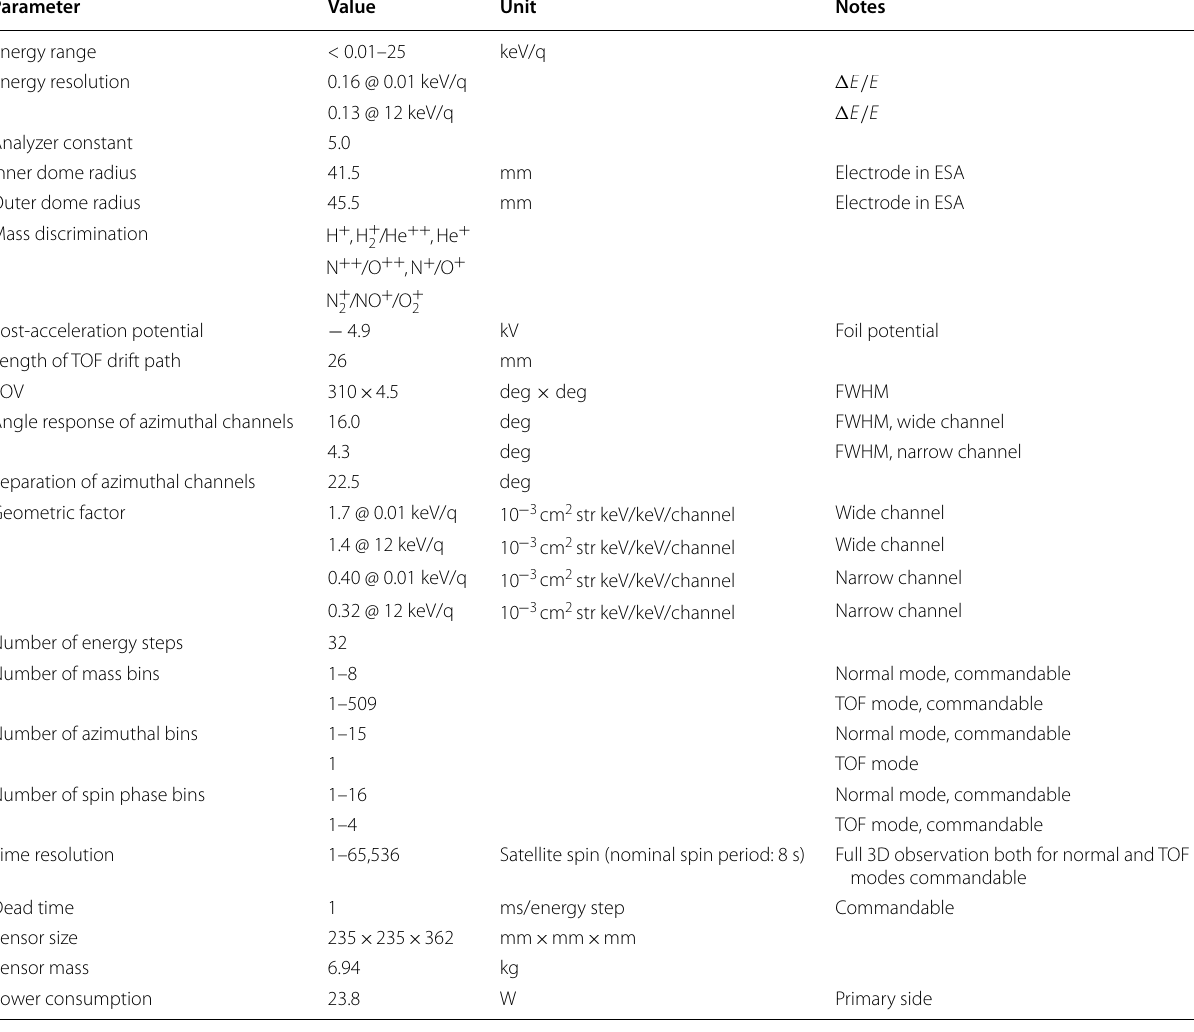
Table 1 Specification and performance of LEPi